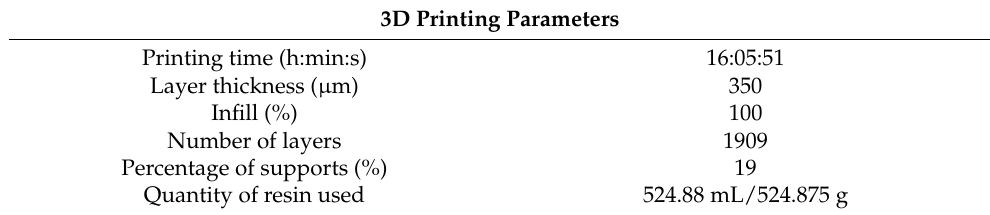
Table 1. 3D printing parameters for the insert mold manufactured by SLA.